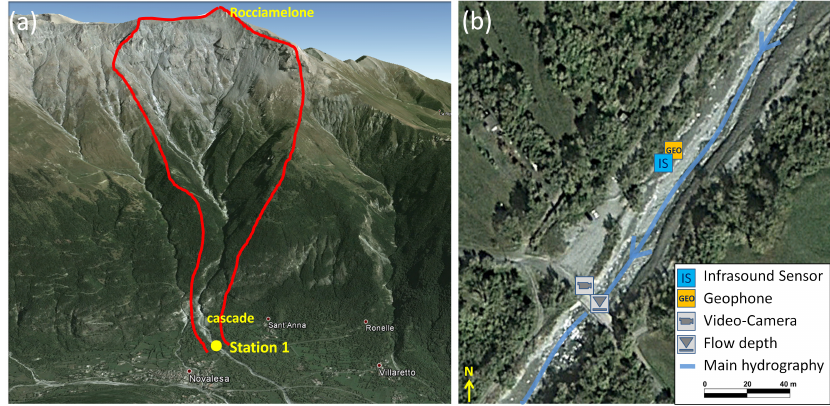
Figure 4. ( a ) overview of the test site Marderello (red line: catchment area); ( b ) closer view of the monitoring station and sensor setup (Source: Google Maps).